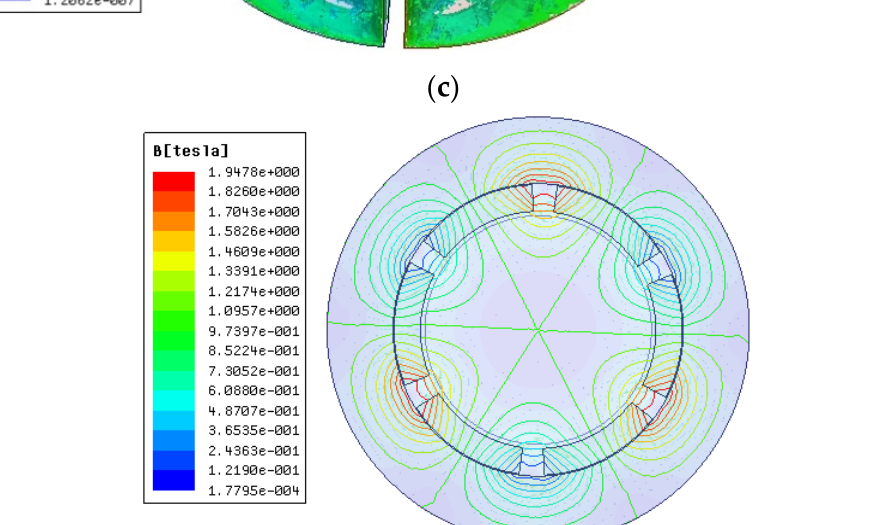
Figure 6. Circumferential air gap density component.